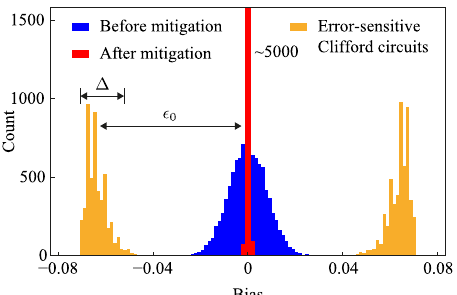
Fig. 5 Distributions of the bias for six-qubit periodic-cycling circuits with 72 two-qubit gates under the gate depolarising noise. The error rate per gate is 0.001. Before error mitigation, the bias distribution of unitary circuits (the blue histogram) has a shape similar to the Gaussian distribution, and the bias distribution of error-sensitive circuits (the orange histogram) is concentrated at two values. When we mitigate errors according to the average depolarising rate ϵ 0 , we move the two peaks to the centre, and the residual bias is determined by the width of the two peaks. Because of the equivalence between the importance Clifford sampling and unitary sampling, the bias of unitary circuits is signi fi cantly reduced after error mitigation (the red